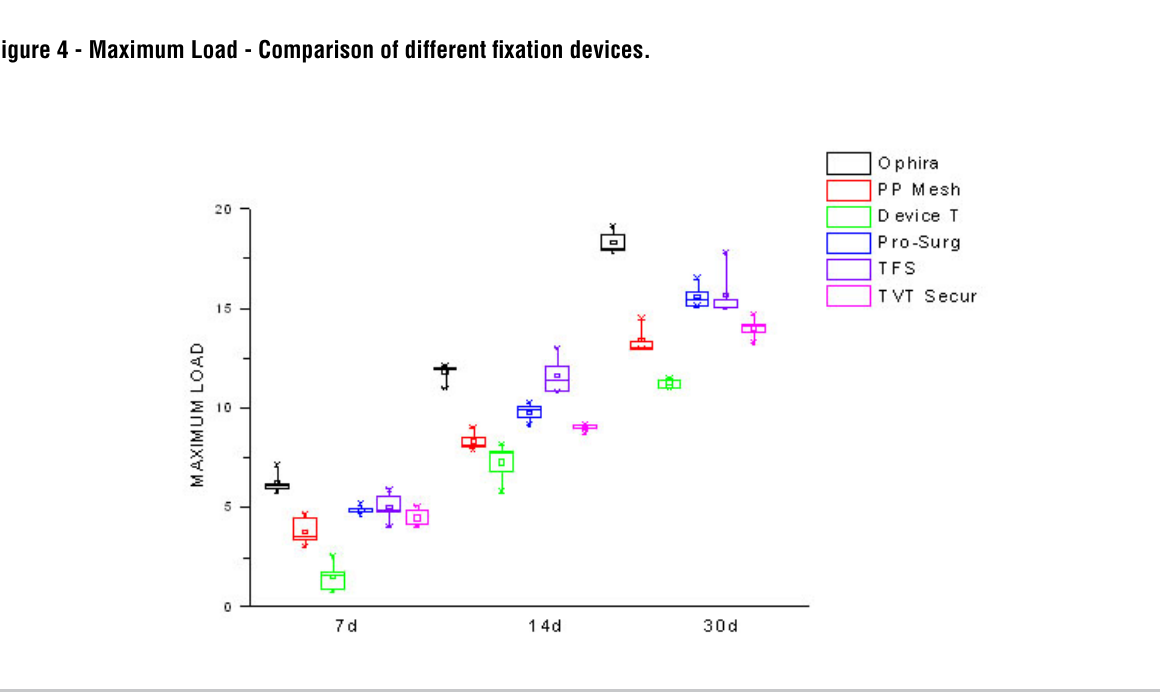
Figure 4 - Maximum Load - Comparison of different fixation